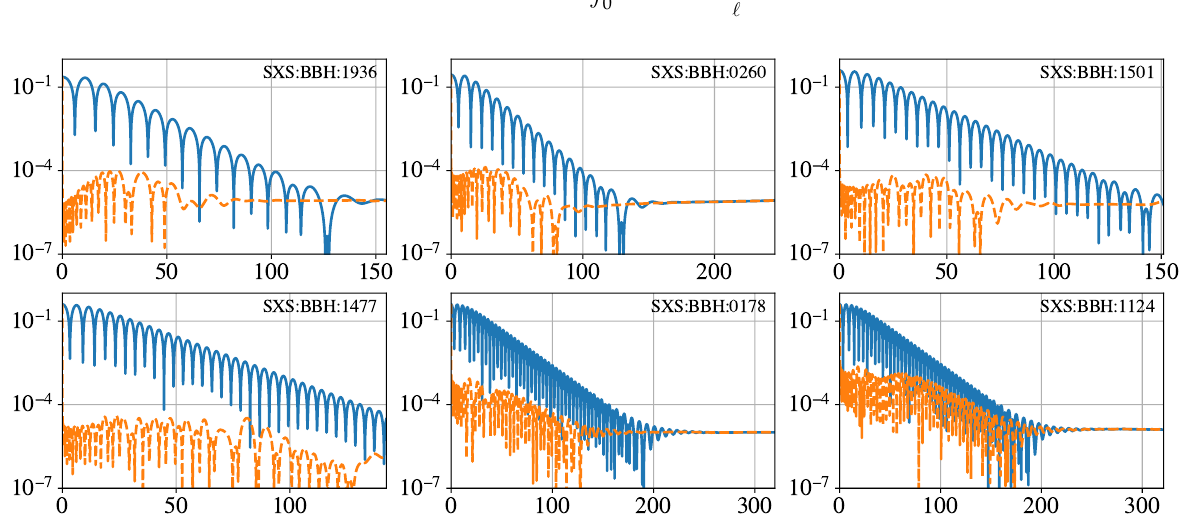
Figure A1. Real part of the ( (cid:96) = 2, m = 2 ) spheroidal harmonic mode (cid:60) ( ˜ h 22 ) of SXS NR waveforms listed in Table A1 and their QNM fit residuals. Each plot corresponds to that in the right panel of Figure 8 in case of SXS:BBH:0305.